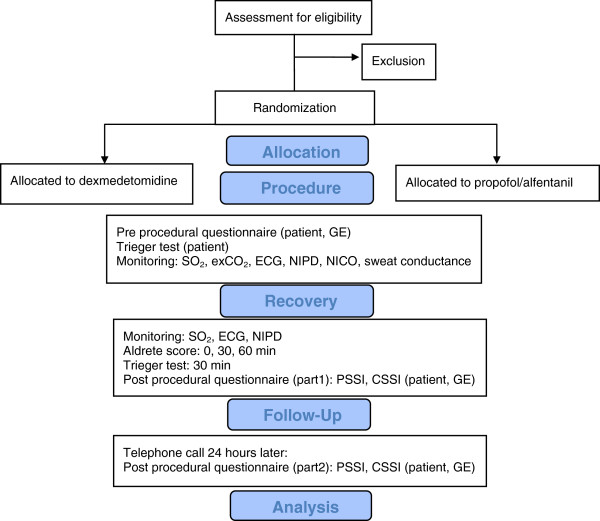
Consort flow diagram.